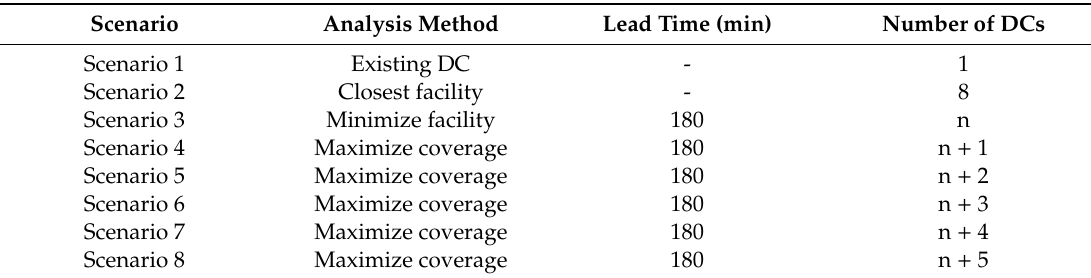
Table 4. Summary of building